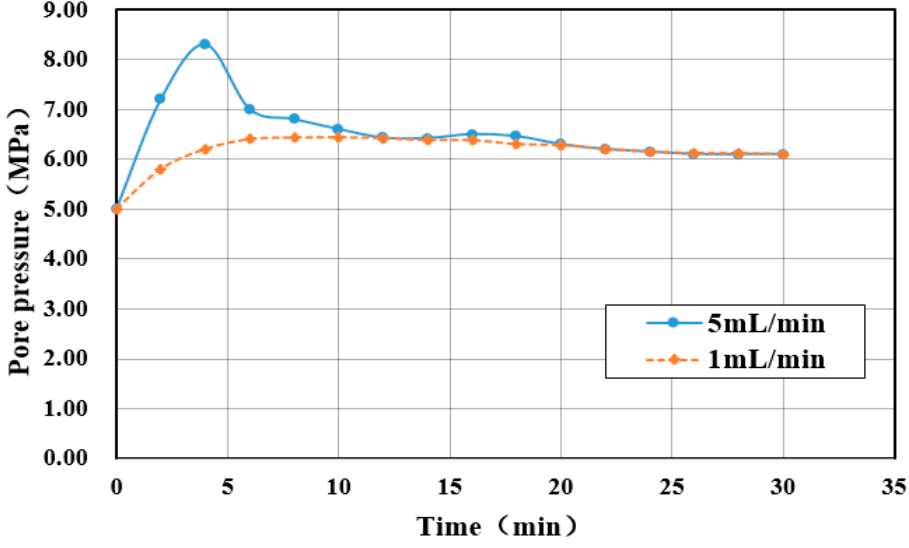
Figure 17. Pore pressure variation with time in the two simulations. Figure 16. Pore pressure variation with time in the two